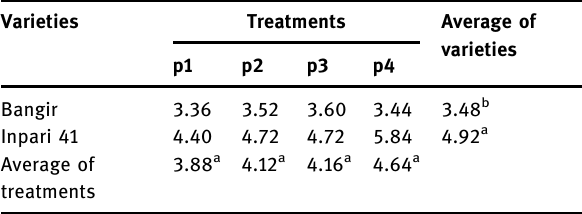
Table 7: Comparisons of grain yield ( t/ha )